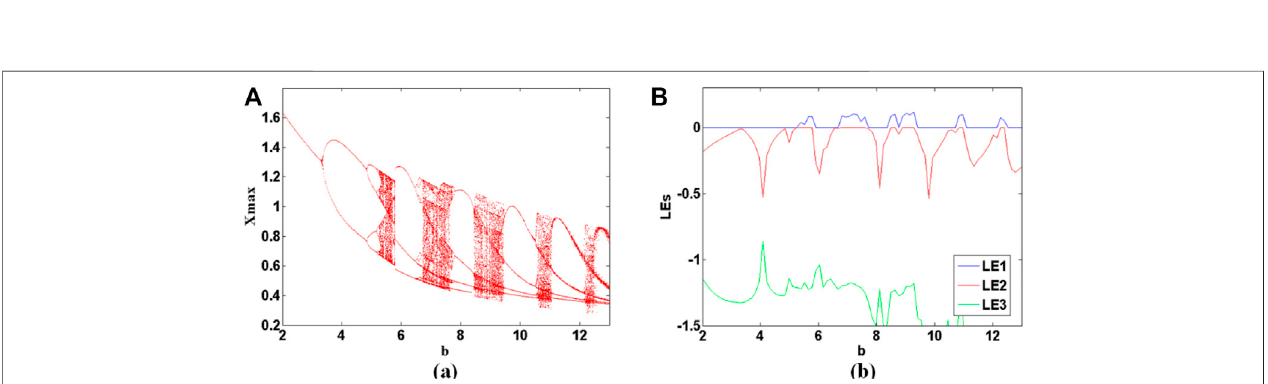
FIGURE11| BifurcationandLyapunovexponents ofsystem(10)with a (cid:1) 2.8, c (cid:1) 1.7, d (cid:1) 2.5and theinitialconditionsis(0,0,0)whentheparameter b variesin[2, 13]. (A) bifurcation, (B) Lyapunov exponents.